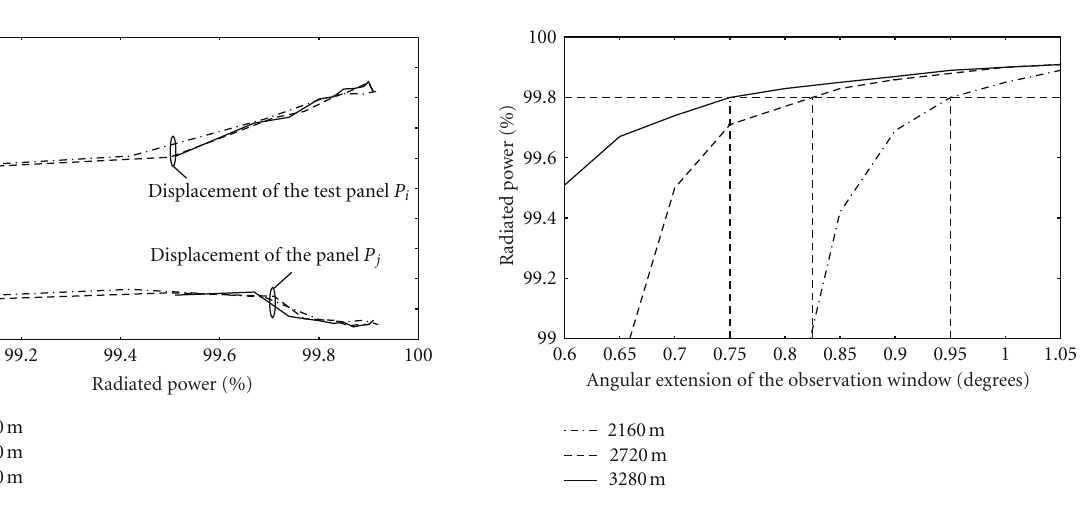
Figure 7: Power radiated by a parabolic reflector with the same geometry of SRT, as a function of the angular extension of the observation